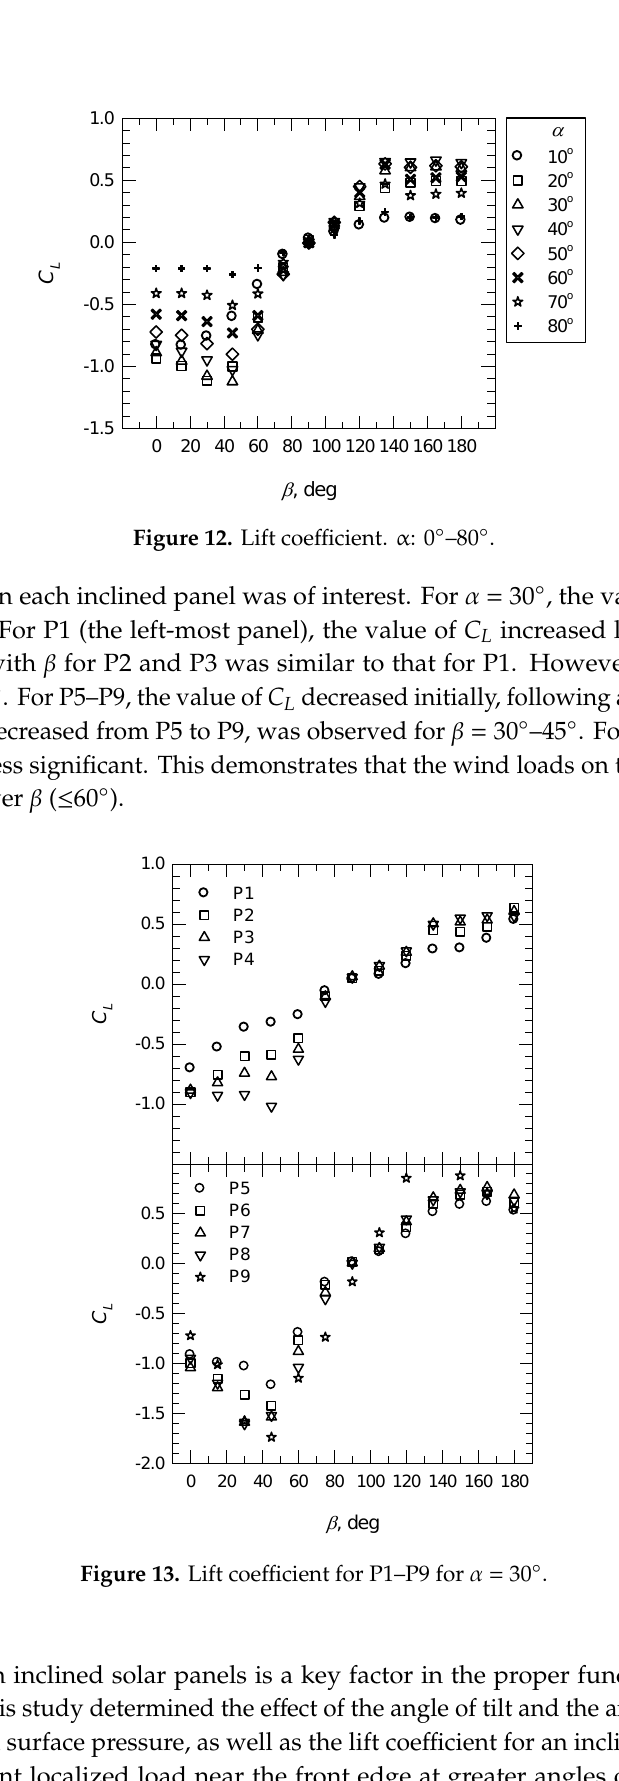
Figure 13. Lift coefficient for P1  P9 for  = 30°. Figure 13. Lift coe ffi cient for P1–P9 for α = 30 ◦